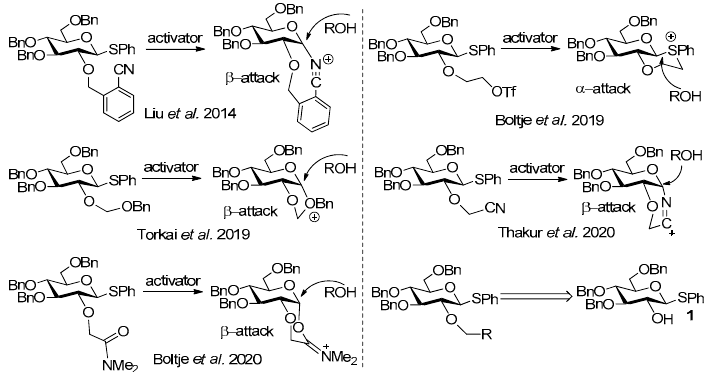
Figure 1. Using NGP from 2-ether groups to control stereoselectivity.